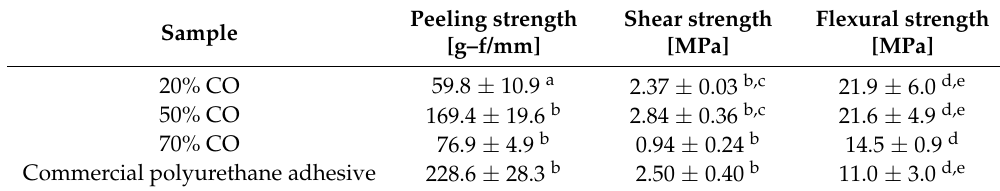
Table 2. Peeling, shear and flexural strengths on bonding wood substrate. Peeling Sample